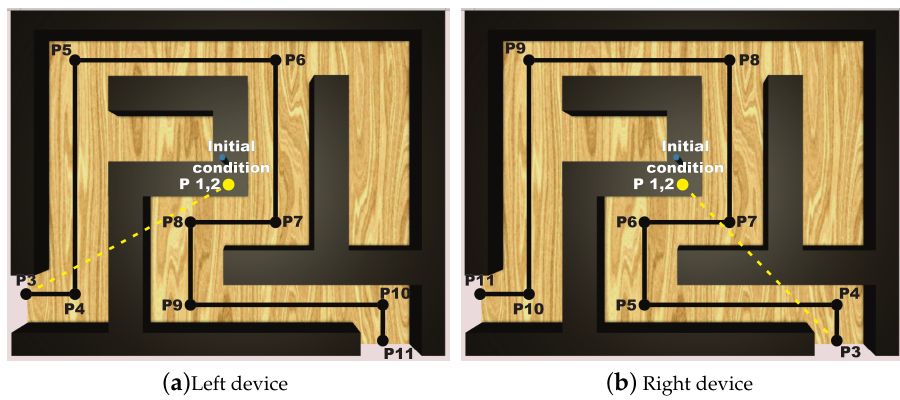
Figure 8. Multiple branch maze, showing the left-hand ( a ) and right-hand ( b ) solution for SCM excercise.